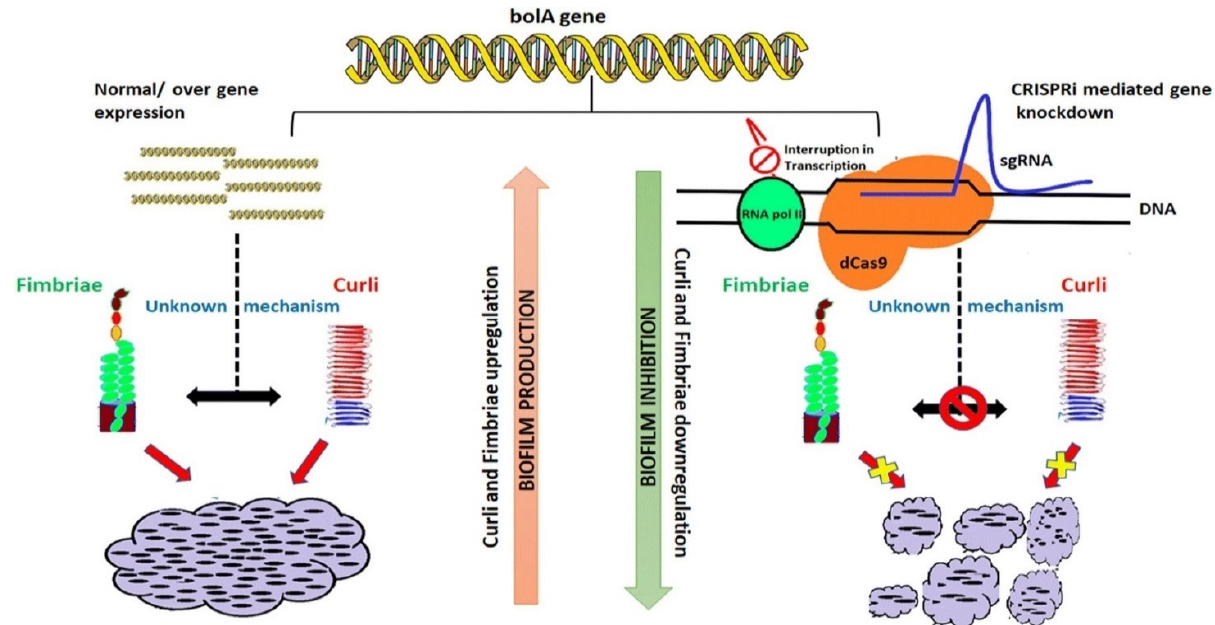
Figure 2. Model of the influence of bolA on the Curli proteins and biofilm (reprinted from an open-access source [45]).